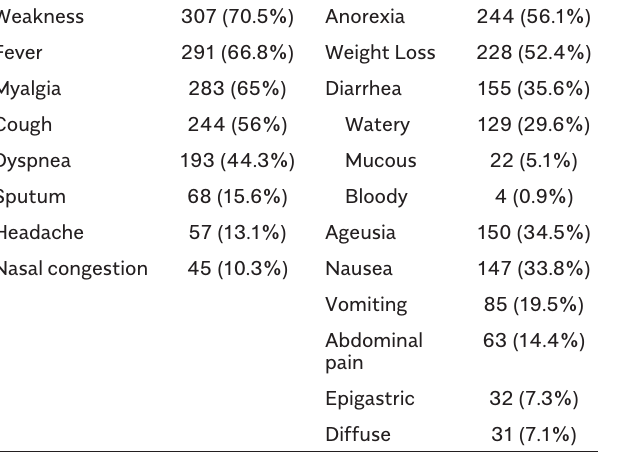
Table 2. Distribution of Symptoms at Admission